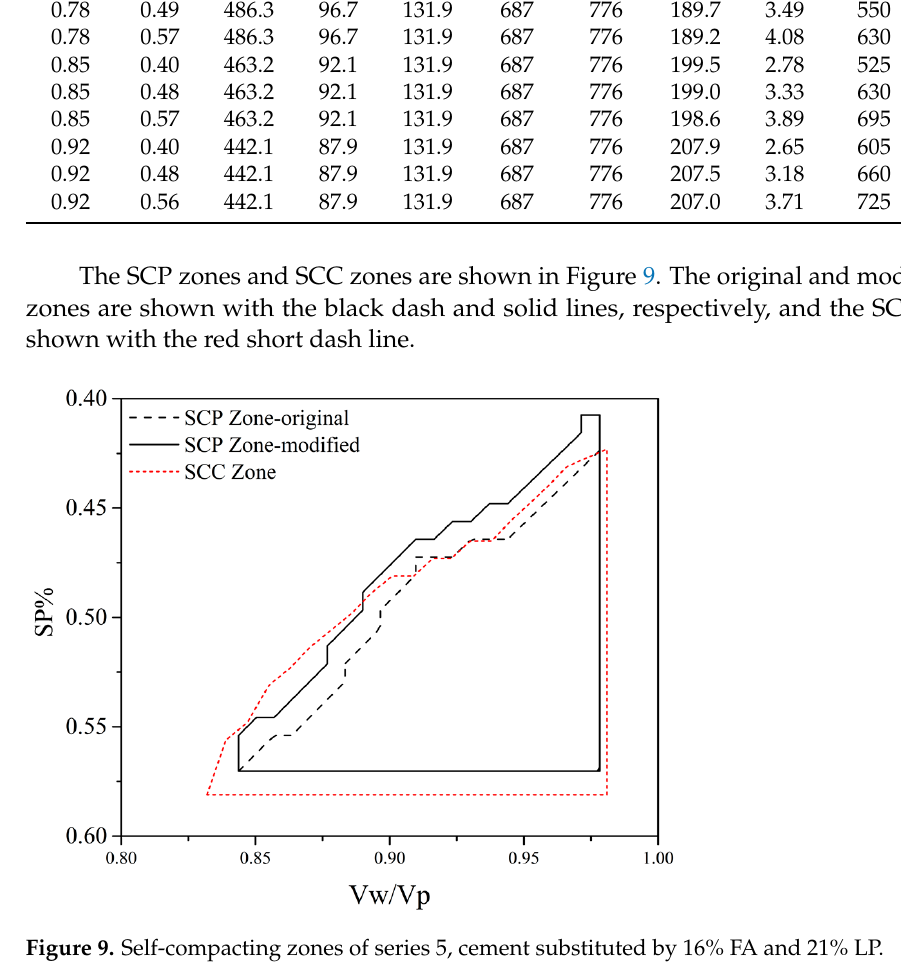
Figure 9. Self-compacting zones of series 5, cement substituted by 16% FA and 21% LP.